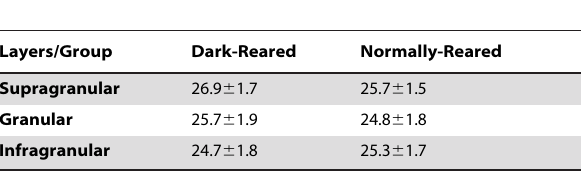
Table 4. Chronic visual deprivation does not affect the numerical densities of ARO-positive cells across cortical layers of V1.